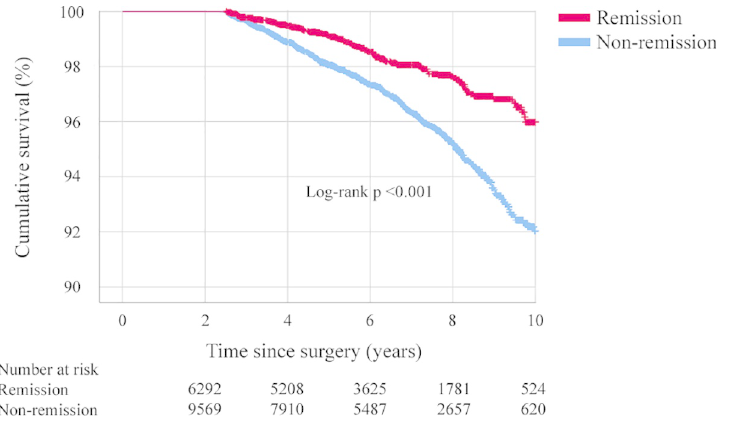
Fig 4. Overall survival in patients experiencing remission of hypertension at 2 years and those not experiencing remission (unadjusted Kaplan–Meier curve).